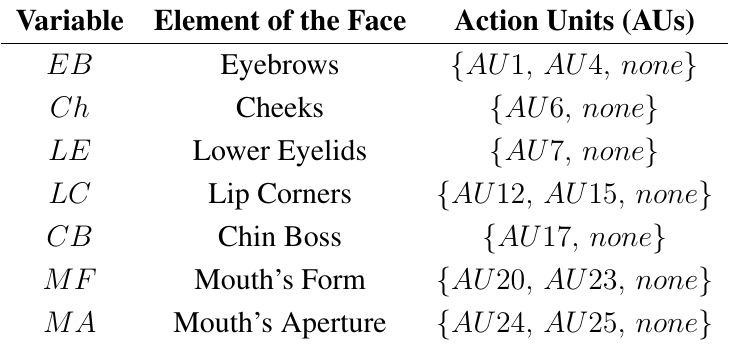
Table 3. Facial expressiveness vector d